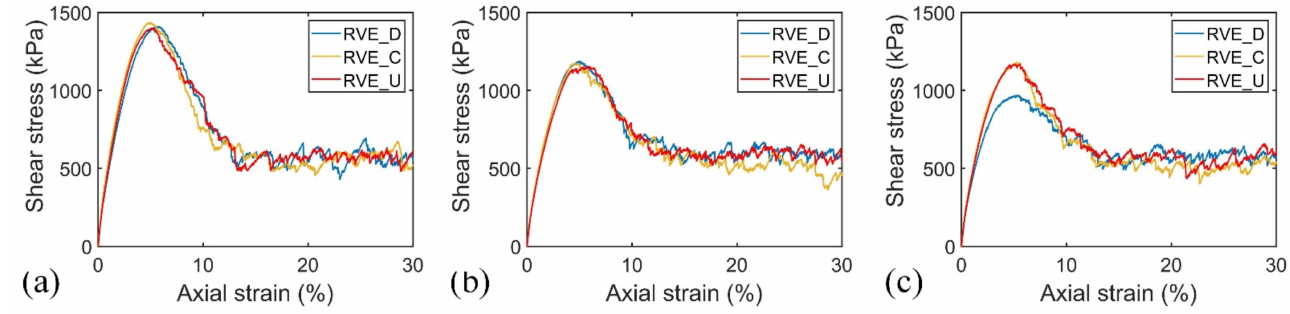
Figure 13. Stress–strain behavior for the specimen FC30 at t = ( a ) 0.0 s; ( b ) 0.1 s; and ( c ) 0.2